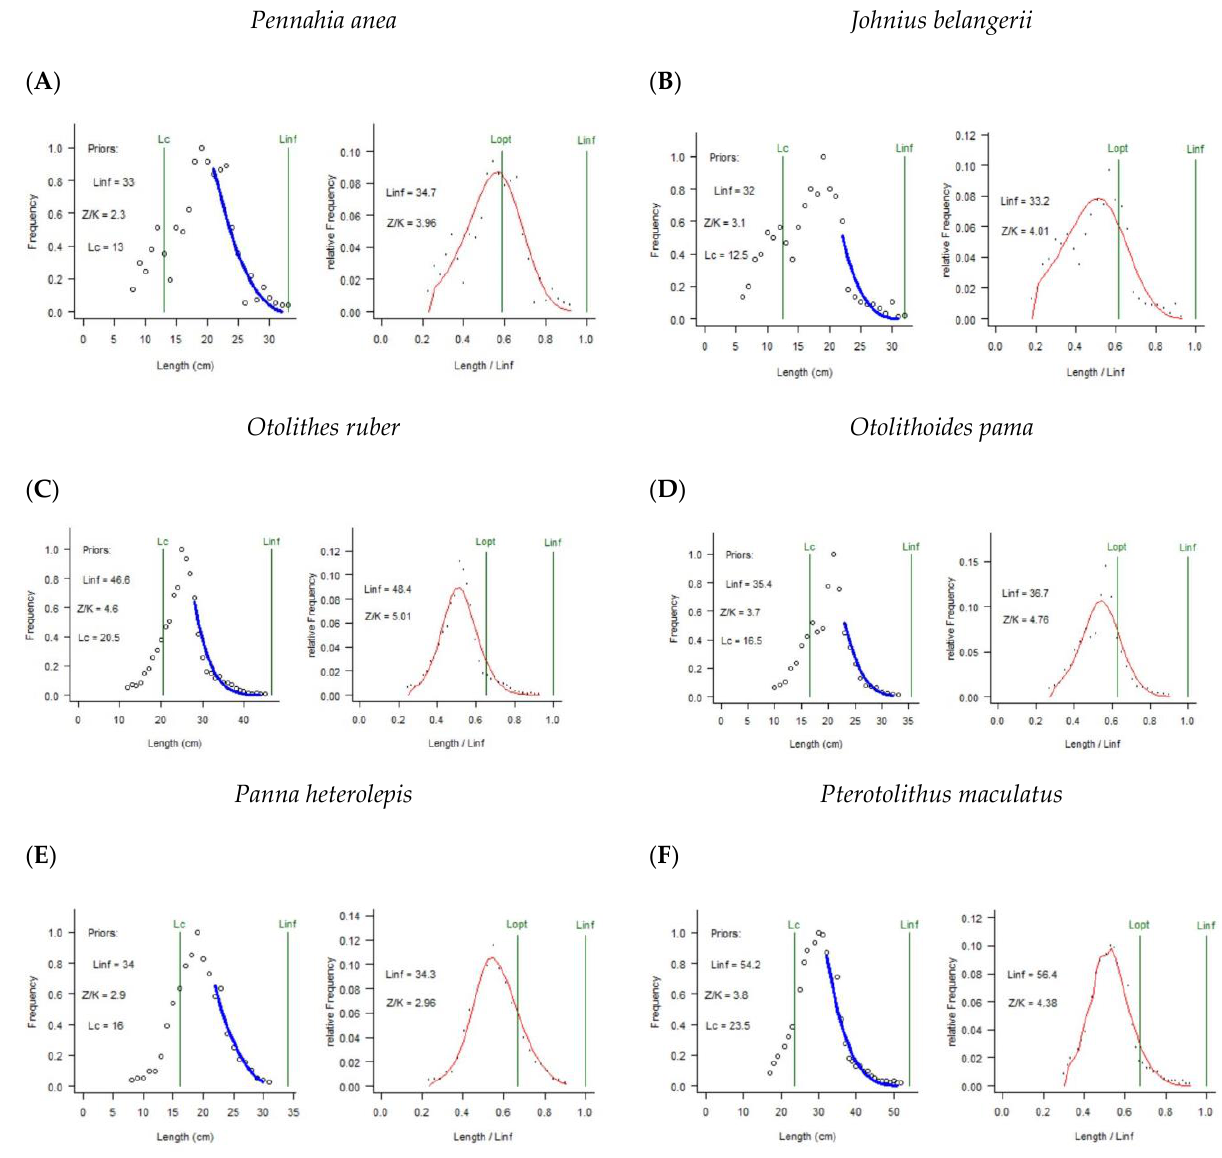
Figure 2. Graphical outputs ( A – F ) of LBB method for the six commercially valuable croaker species from the BoB, Bangladesh coast. Where Lc = length at first captured, L inf = asymptotic length of this species, and L opt = length at which the maximum sustainable yield is obtained. The left curve of each species output indicates the fitting of the model to the length data and the right curve shows the prediction of LBB method. Table 3. Estimated results of Six Sciaenidae species in BoB by the length-based Bayesian biomass (LBB)